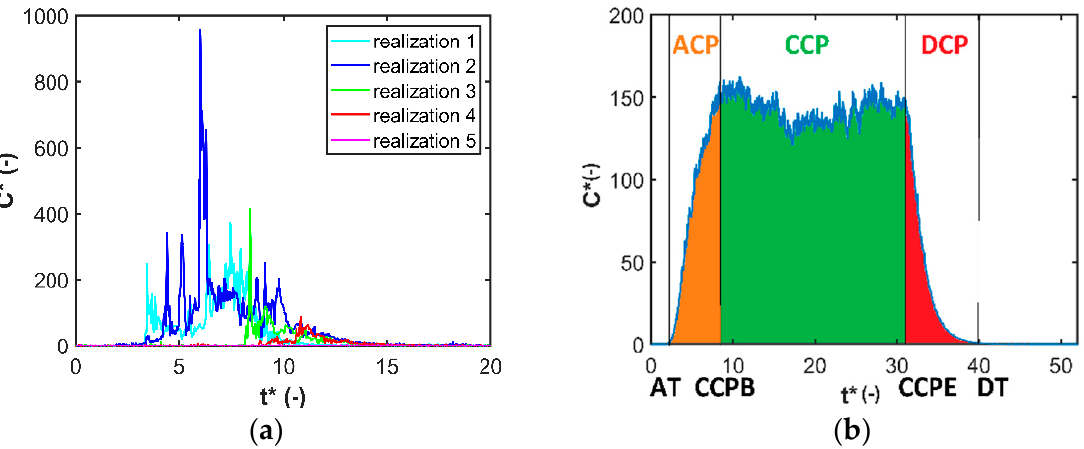
Figure 3. Finite-duration gas release concentration time series: ( a ) a few individual realizations; ( b ) mean behavior (the blue signal represents the concentration averaged over all realizations at individual times after the gas release; ACP stands for the arrival cloud phase, CCP the central cloud phase and DCP the departure cloud